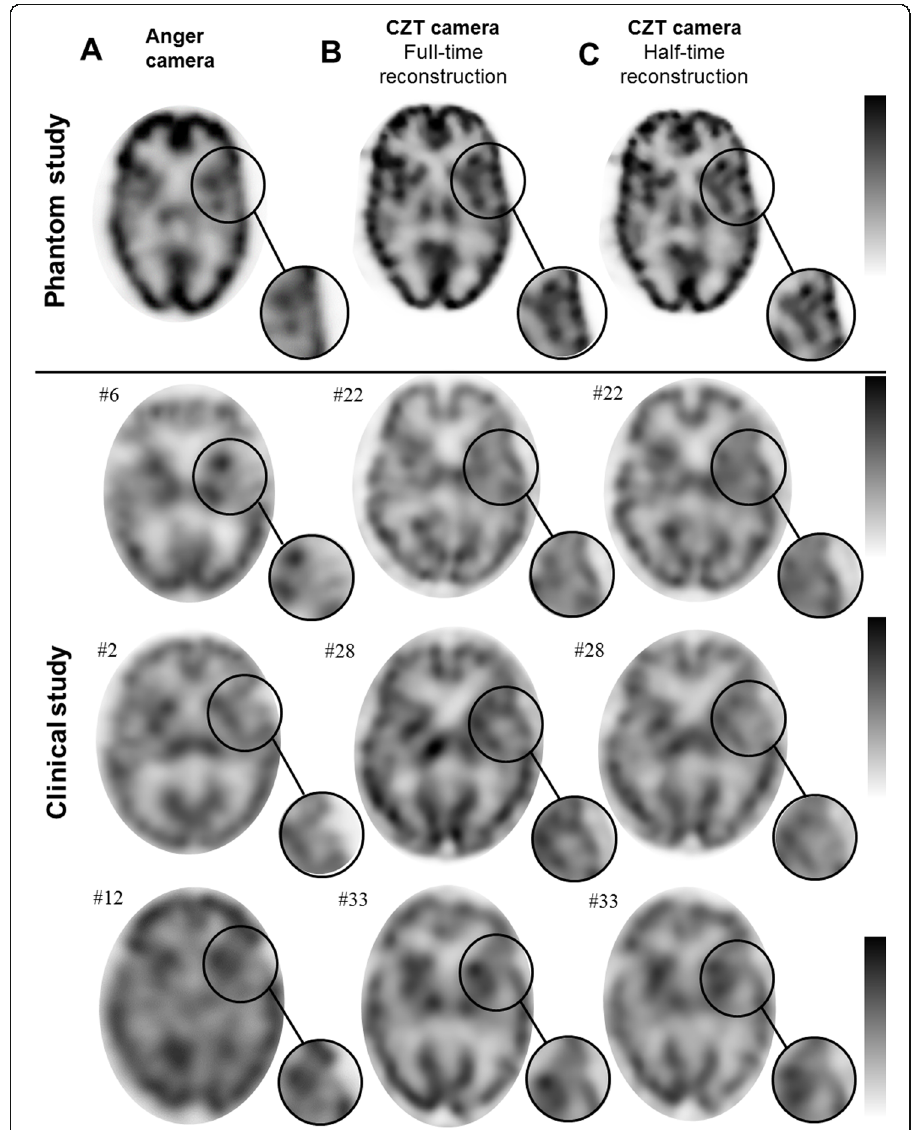
Fig. 3 Representative examples of median axial brain 99m Tc-HMPAO SPECT slices obtained with the Anger camera ( a ) and with the CZT camera for full-time (i.e., 30 min, b ) and half-time (i.e., 15 min, c ) recordings, for the brain-phantom (upper slices) and for three matched pairs of patients imaged with the Anger or CZT